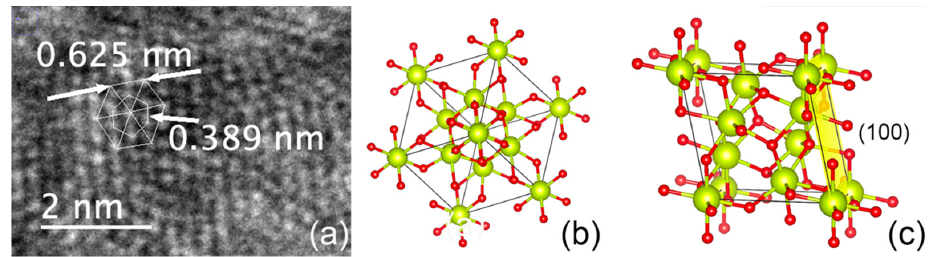
Figure 8. ( a ) TEM image from the dissolution of S5NBCe glass and the schematic diagram of Ce 7 O 12 ( b ) cross-section of a (101) plane ( c ) rhombic unit cell. Our measured distances also show us the existence of triclinic Ce 11 O 20 nanocrystals. Figure 9a indicates a (100) plane of nanocrystal structure of Ce 11 O 20 along with the schematic diagram of Ce 11 O 20 schematic diagram of Ce 11 O 20 with (110) plane indicated by the yellow.